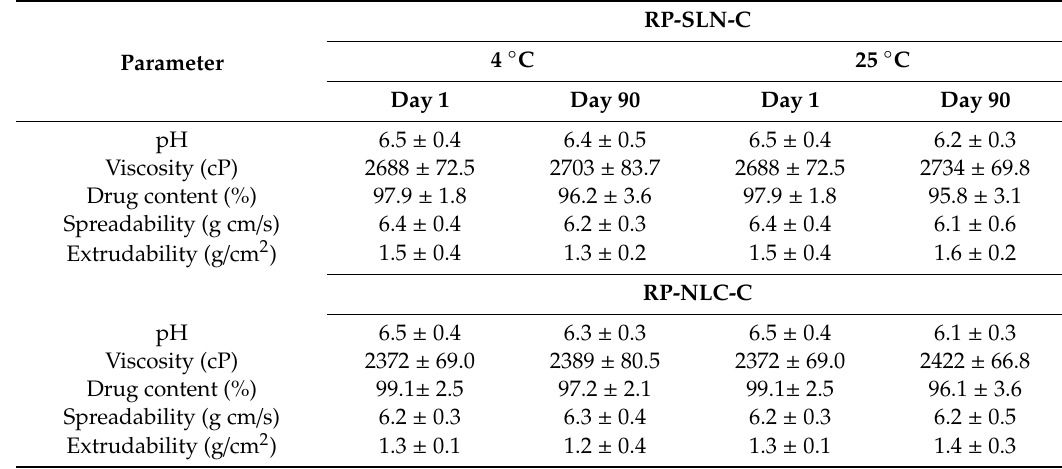
Table 7. E ff ect of storage conditions on pH, viscosity, assay, spreadability, and extrudability of optimized RP-SLN-C and RP-NLC-C formulation at refrigerator and room temperature (mean ± SD, n = 3).